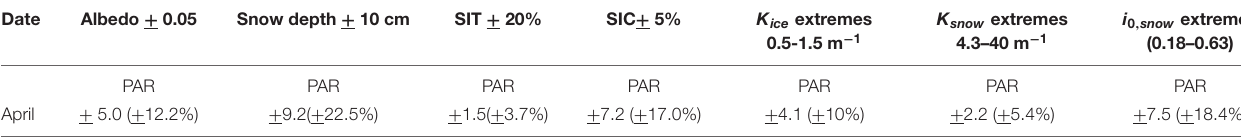
TABLE 3 | Impact of uncertainties in physical sea ice/snow parameters used as input to the Beer–Lambert law on under-ice PAR in µ mol m − 2 s − 1 . Date